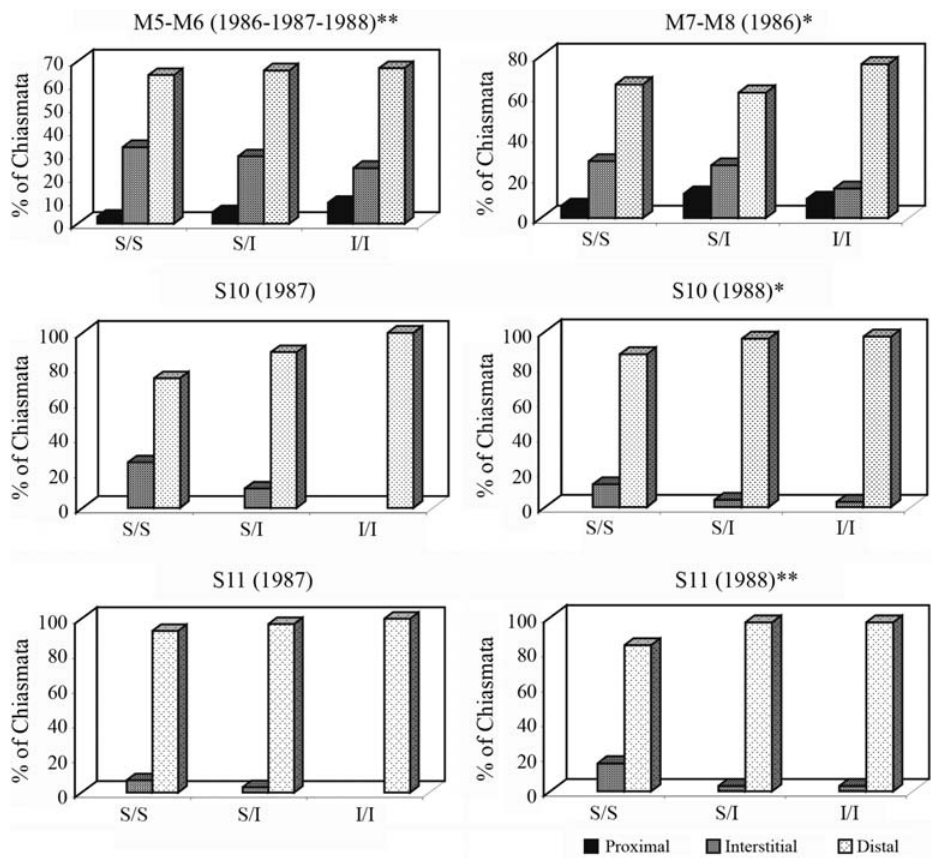
Figure 2 - Chiasma distribution patterns in medium (M) and small (S) pairs of standard homozygotes (S/S), heterozygotes (S/I) and homozygotes for the M4 inversion in Sinipta